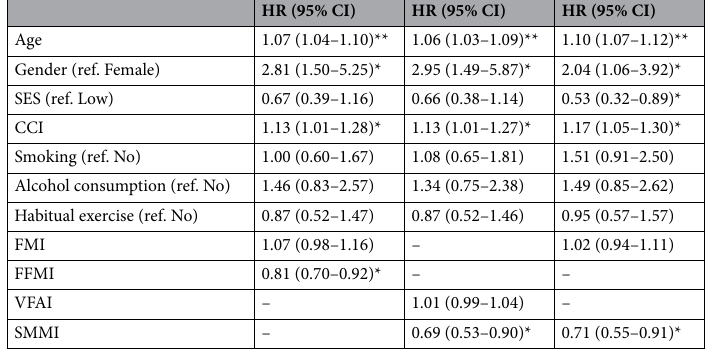
Table 4. Cox proportional hazard model analysis of the association between the FMI, FFMI, SMMI, and VFAI and all-cause mortality (N = 1,199). SES: socioeconomic status; CCI: Charlson comorbidity index; FMI: fat mass index. FFMI: fat free mass index; VFAI: visceral fat area index, and SMMI: skeletal muscle mass index. * p < .05; ** p < .001.